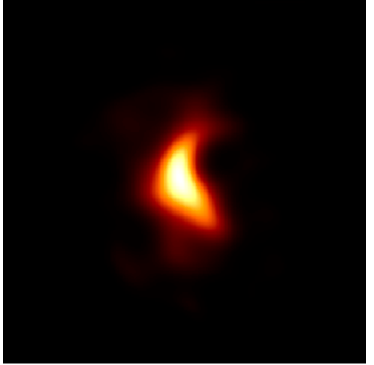
Figure 8. Synthetic image of the time variable black hole Sgr A* that could be recovered with an array of 8 radiotelescopes and averaging 8 epochs (from [25]).